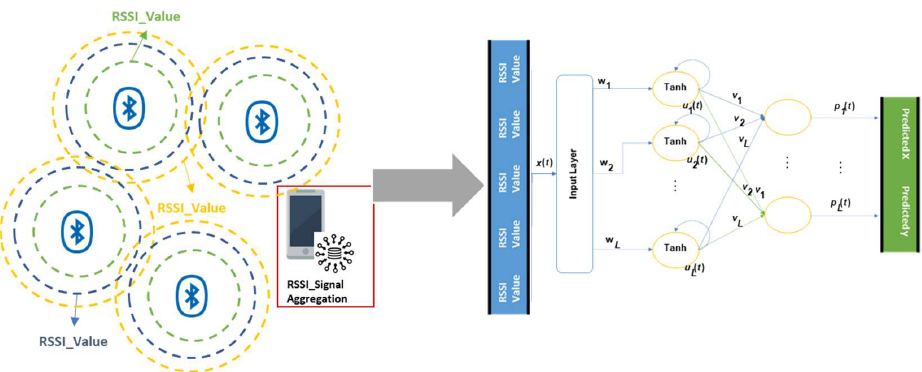
Figure 1. Indoor Cadastral Technical Framework —